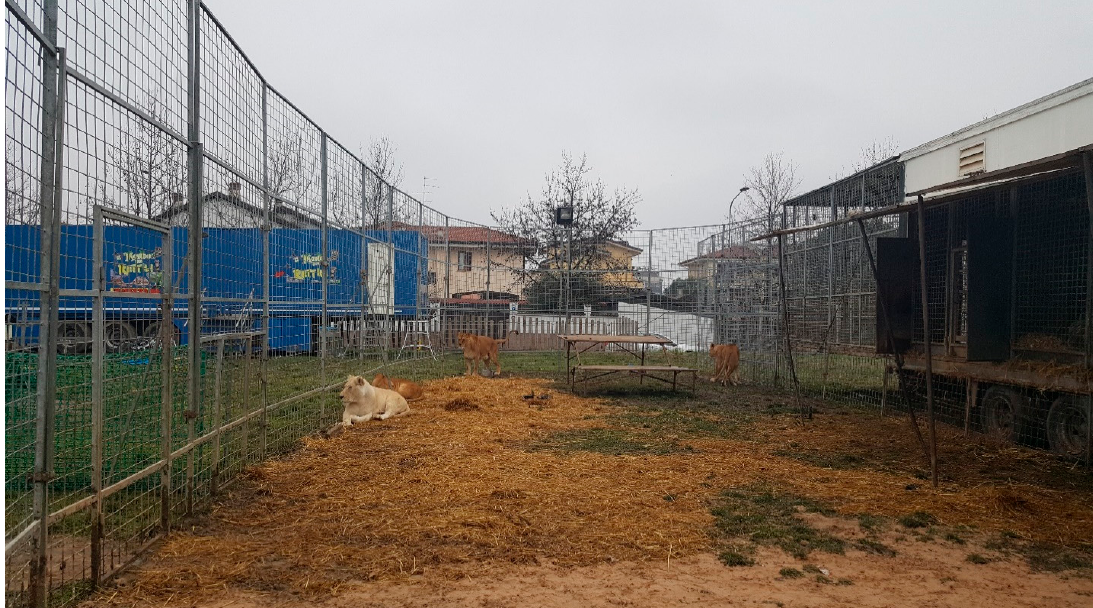
Figure 1. One of the exercise pens containing four of the lions used in this study. A second pen is visible in the background. The dens, which also served as travel cages, are located in the trailer to the right.